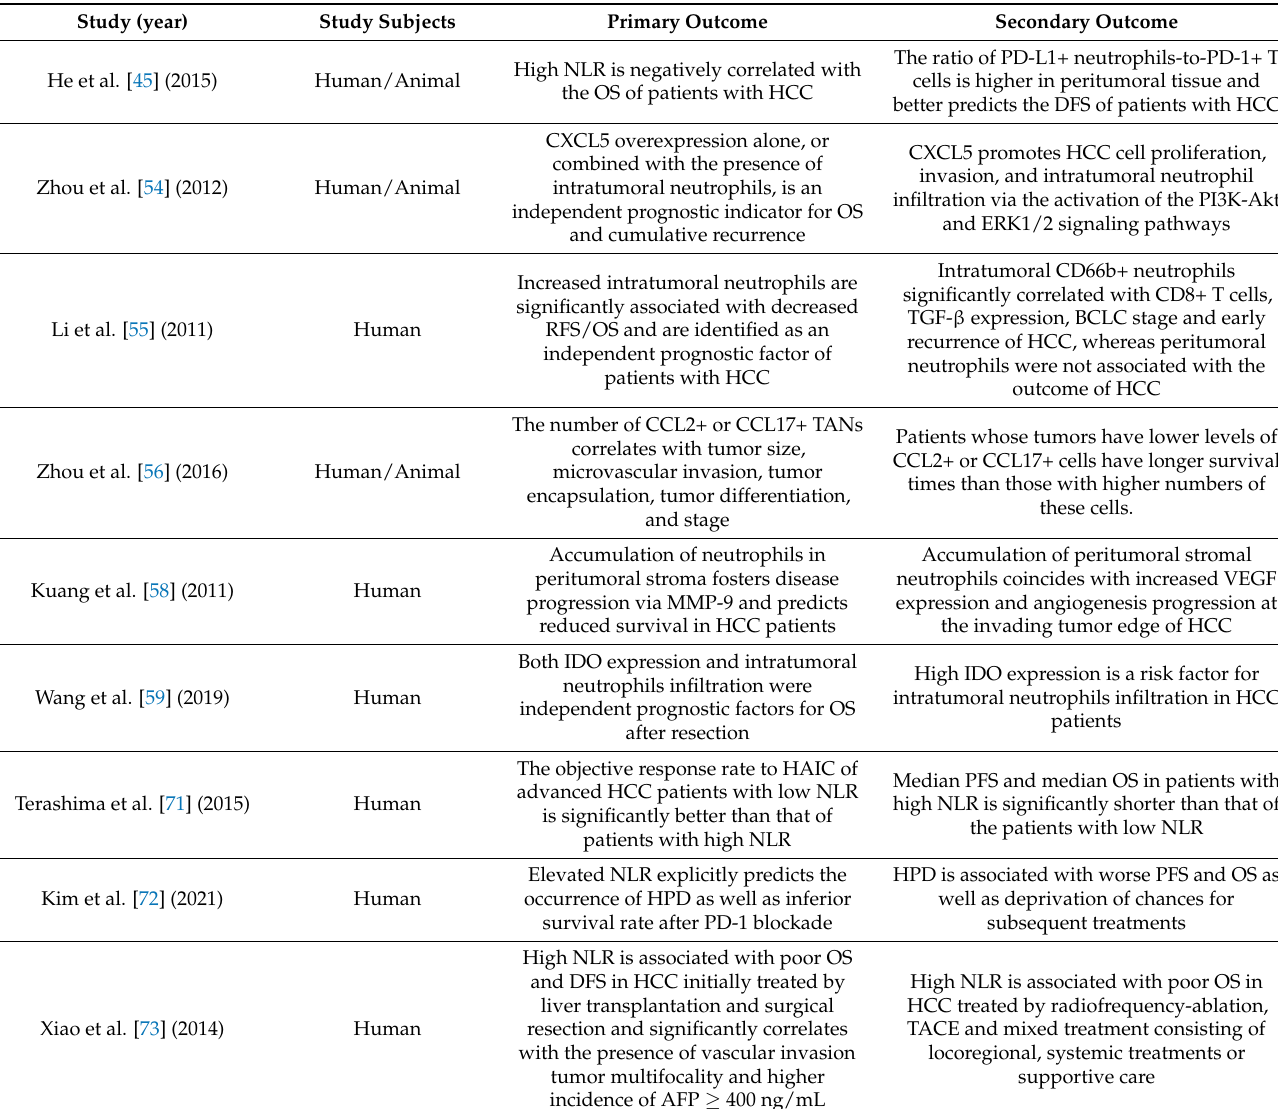
Table 2. Summary of studies evaluating the role of TANs in HCC